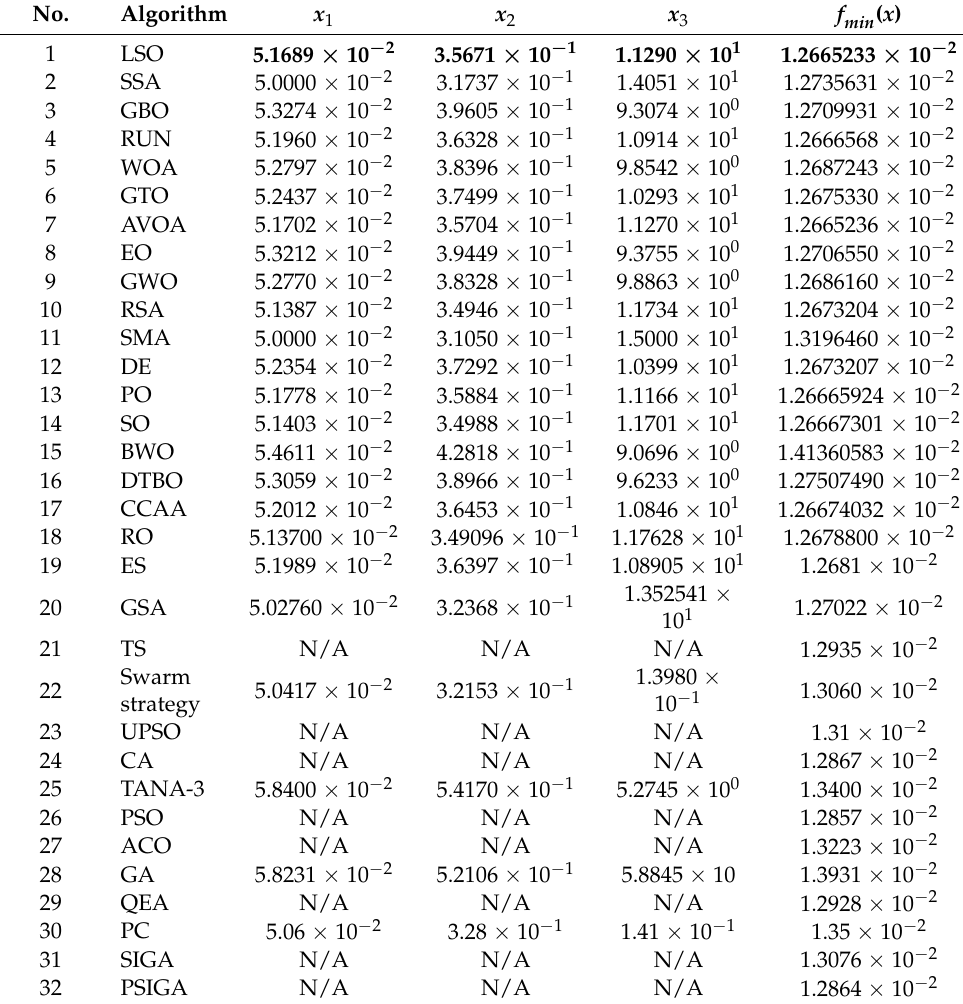
Table 17. Comparison of the results for tension/compression spring design optimization